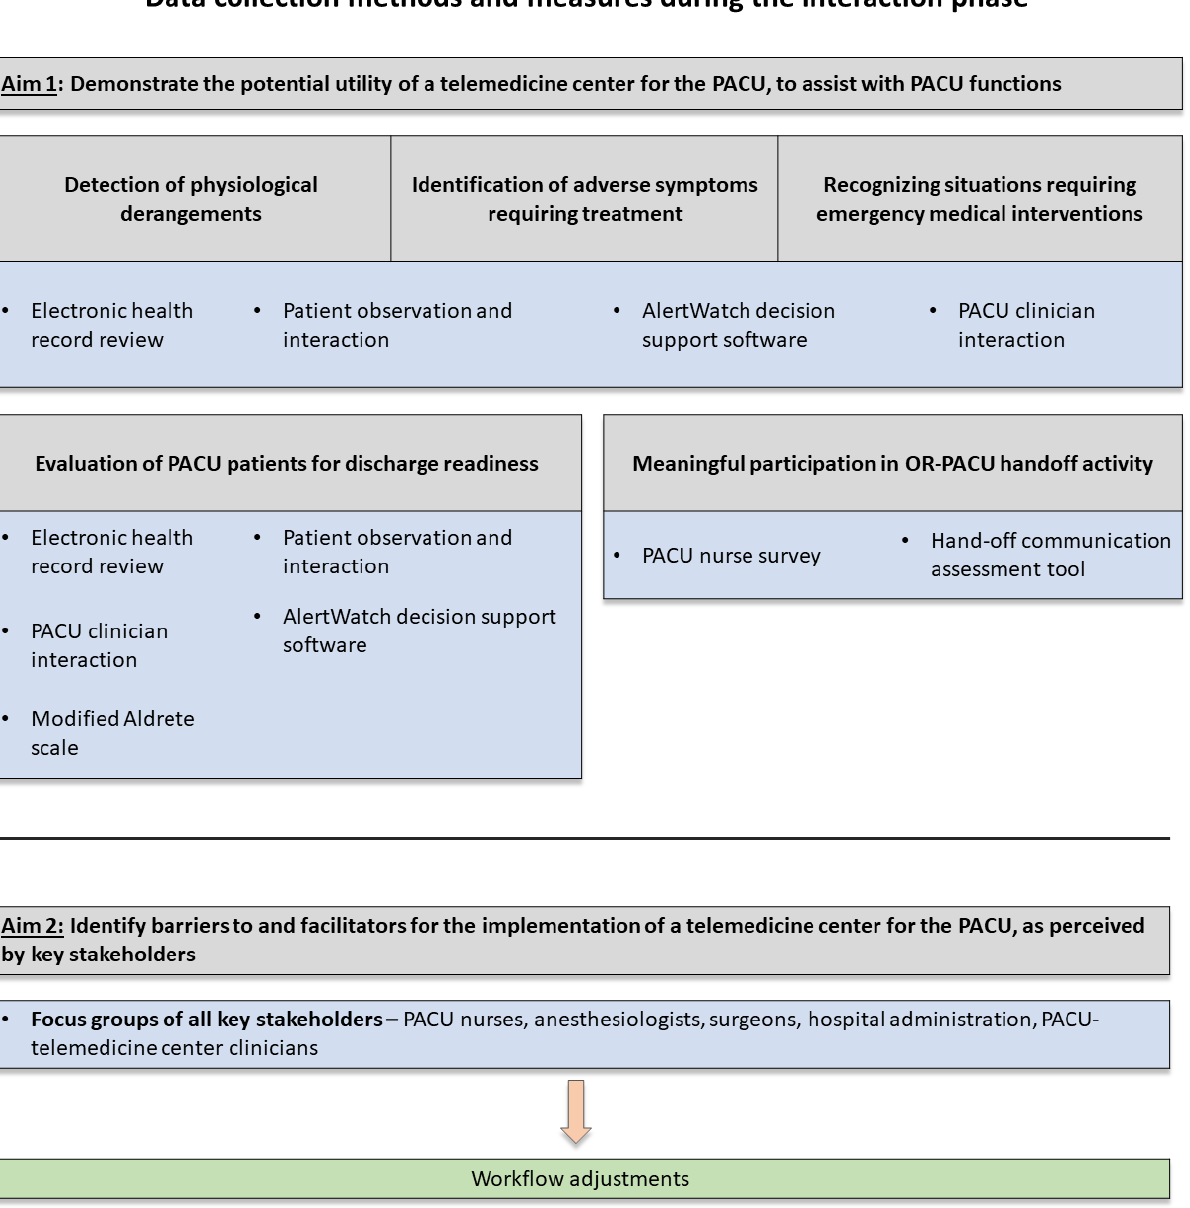
Figure 3. Overview of data collection methods and outcome measures during the interaction phase of a before-and-after proof- of-concept study for a telemedicine center for the post-anesthesia care unit